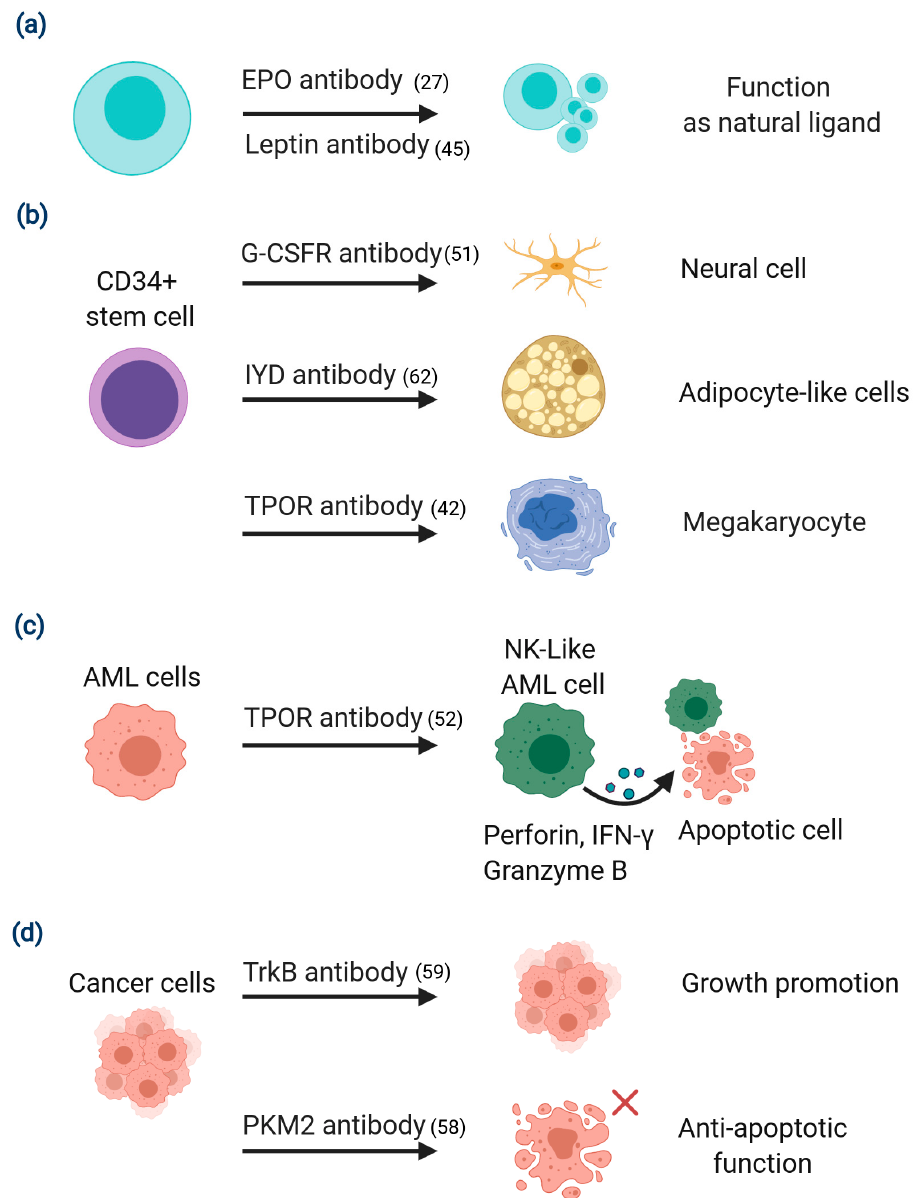
Figure 2. Some examples of antibody libraries as a tool to discover functional antibodies and receptor pleiotropism. Functional antibodies can isolate from target-based or phenotypic-based screening from a combinatorial antibody library. Agonist antibodies that are generated against signaling receptors often induce the same cellular response as the natural agonist ligand for the receptor, or the agonist antibody induces a different cell fate than the natural ligand, even though they both bind to the same receptor. ( a ) The erythropoietin (EPO) agonist or the leptin agonist antibody have the same biological activity as a natural ligand. ( b ) Exposure of CD34+ bone marrow stem cells with different functional agonist antibodies, e.g., Granulocyte Colony Stimulating Factor Receptor (G-CSFR) specific agonist antibody, iodotyrosine deiodinase (IYD) antibody, and thrombopoietin receptor (TPOR) antibody can differentiate into nerve cells, adipocyte-like cells, and megakaryocytes, respectively. ( c ) Exposure of acute myeloid leukemia (AML) cells to TPOR antibody promotes their differentiation into natural killer (NK)-like AML cells that can induce apoptosis in non-differentiated AML cells. ( d ) Exposure of cancer cells to TrkB antibody or PKM2 antibody that promote tumor growth or anti-apoptotic function. Abbreviations: erythropoietin (EPO), Granulocyte Colony Stimulating Factor Receptor (G-CSFR) thrombopoietin receptor (TPOR), acute myeloid leukemia (AML), natural killer (NK), interferon- γ (IFN- γ ), iodotyrosine deiodinase (IYD), tropomyosin receptor kinase B (TrkB), pyruvate kinase M2